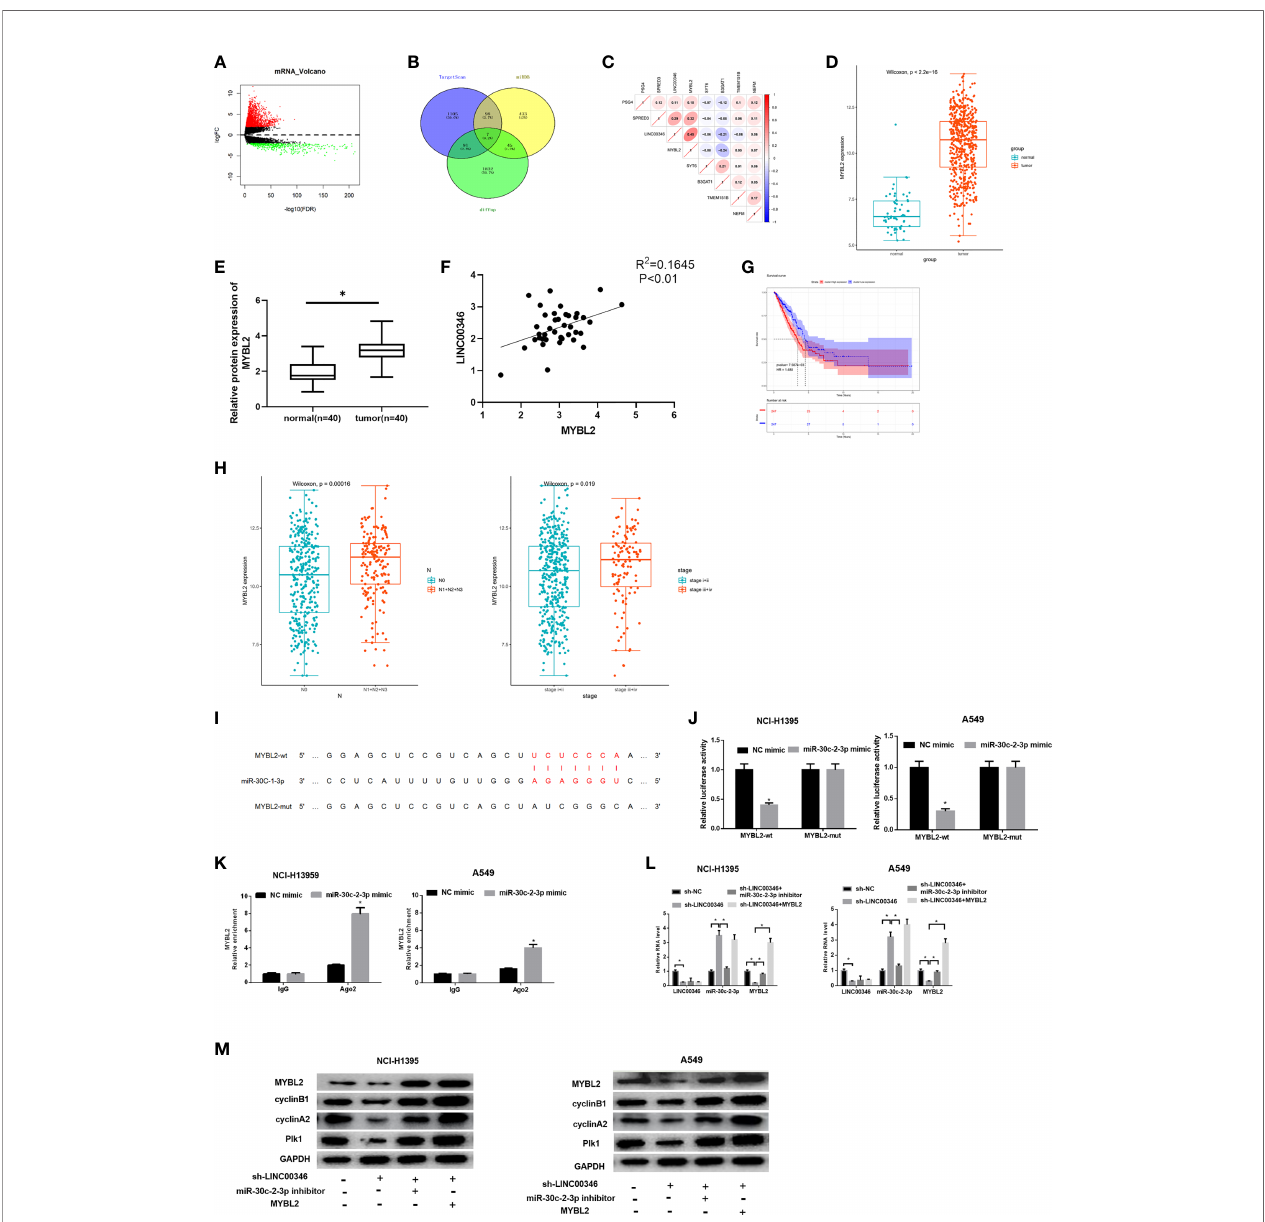
FIGURE 5 | LINC00346 regulates CELL CYCLE signaling pathway by sponging miR-30c-2-3p and targeting MYBL2. (A) Volcano plot of DEmRNAs in TCGA-LUAD dataset; (B) Venn diagram of predicted mRNAs and up-regulated DEmRNAs; (C) Pearson correlation analysis of LINC00346 and MYBL2; (D) The boxplots of MYBL2 expression in normal (green) and tumor (red) samples; (E) qRT-PCR was used to detect the expression of MYBL2 mRNA in 40 pairs of clinical samples; (F) Correlation analysis indicates a highly positive correlation between LINC00346 and MYBL2 expression in 40 LUAD tissue samples; (G) Kaplan-Meier curves of MYBL2 expression in TCGA-LUAD (red for high-expression group and blue for low-expression group); (H) The expression of MYBL2 in different clinical stages and N stage of LUAD; (I) The binding sites of miR-30c-2-3p and MYBL2 predicted by TargetScan; (J) Dual-luciferase reporter gene assay was used to determine the targeted relationship between miR-30c-2-3p and MYBL2; (K) The enrichment of MYBL2 in Ago2 immunoprecipitation was detected by RIP; (L) qRT-PCR veri fi ed the expression of LINC00346, miR- 30c-2-3p and MYBL2 in each treatment group; (M) Western blot was used to detect the expression of MYBL2 and cell cycle related proteins in each group. * P <